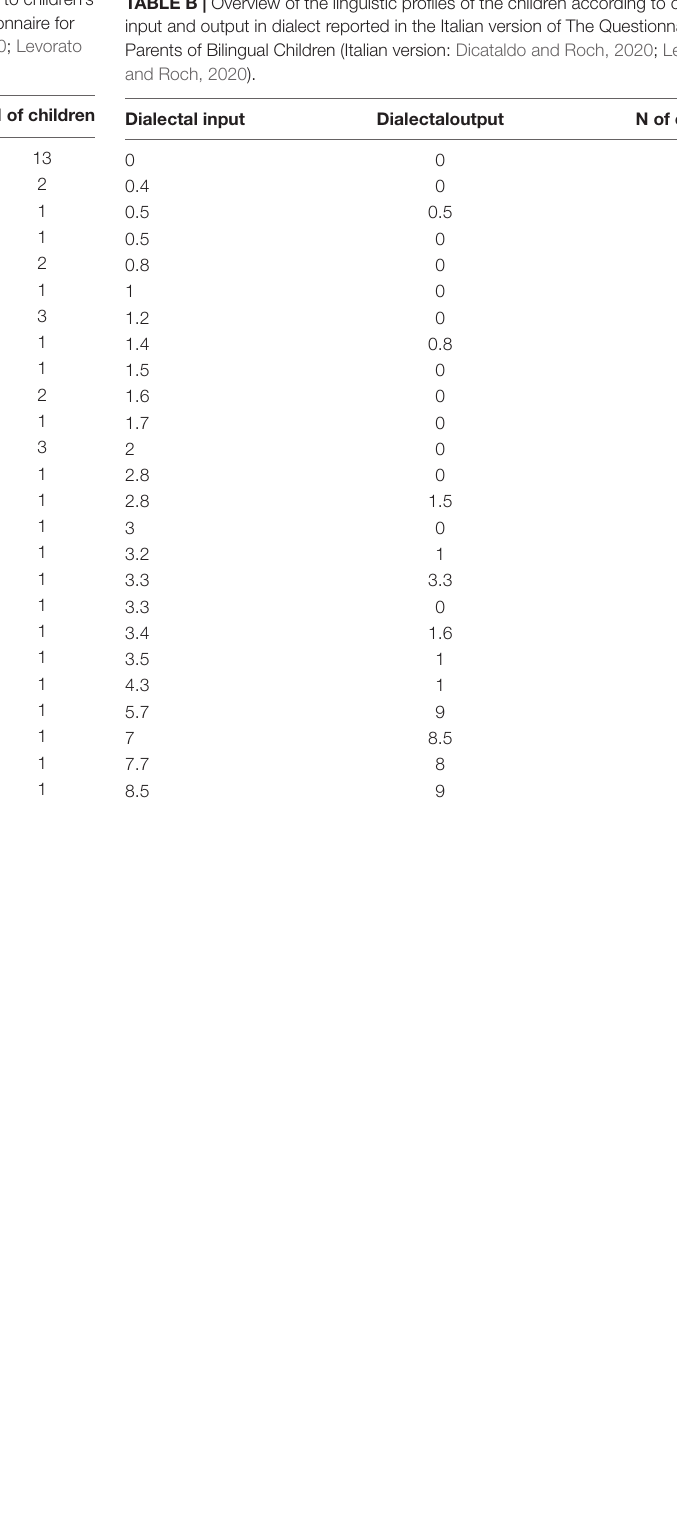
TABLE B | Overview of the linguistic profiles of the children according to children’s input and output in dialect reported in the Italian version of The Questionnaire